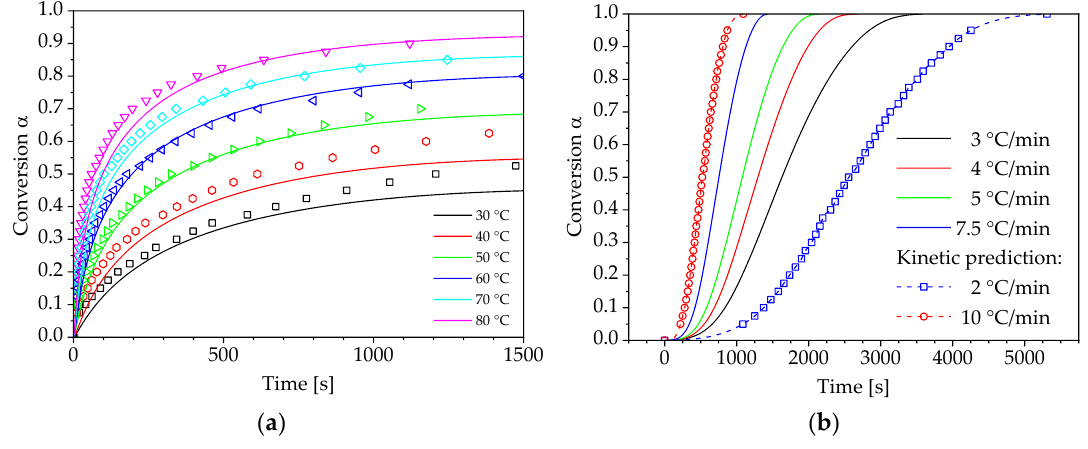
Figure 11. Kinetic prediction of the PUR curing process (— experimental data, (cid:3) model prediction): ( a ) isothermal curing conditions; ( b ) non-isothermal curing conditions.